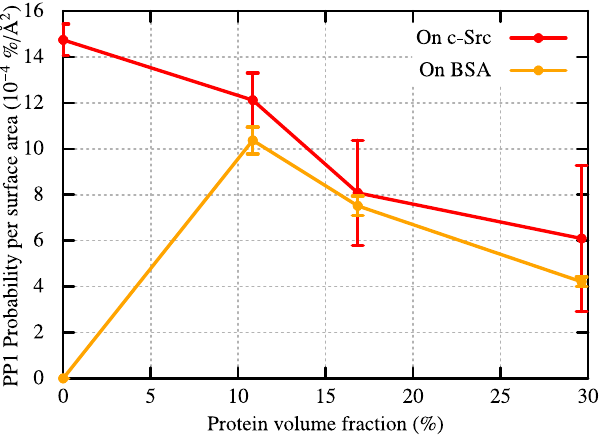
Fig. 2 The probability of fi nding PP1 per unit protein surface area (Å 2 ) on the surface regions of c-Src kinase and BSA. The probability is estimated from the solvent-accessible surface area (SASA) of the crystal structures of c-Src ( S Src = 13630.75 Å 2 ) and BSA ( S BSA = 26680.10 Å 2 ). The SASAs are calculated with the Spatial decomposition analysis (SPANA) tool 78 . Error bars indicate the standard error of the mean from seven trajectories for each system.